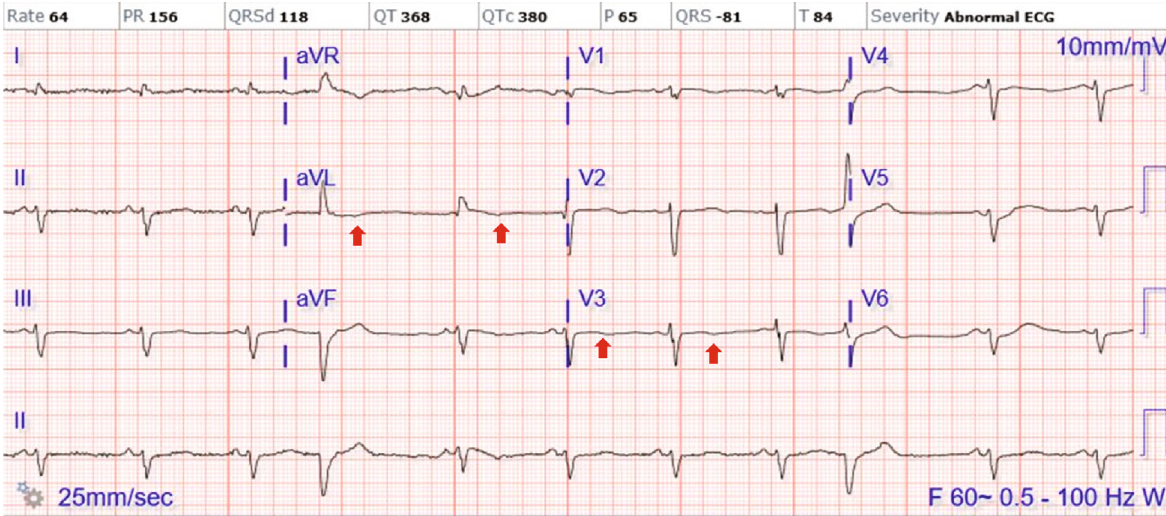
Figure 1: Electrocardiogram on a day of admission with sinus rhythm, left axis deviation, T wave inversion in aVL, and V3 and multiple premature ventricular contraction.